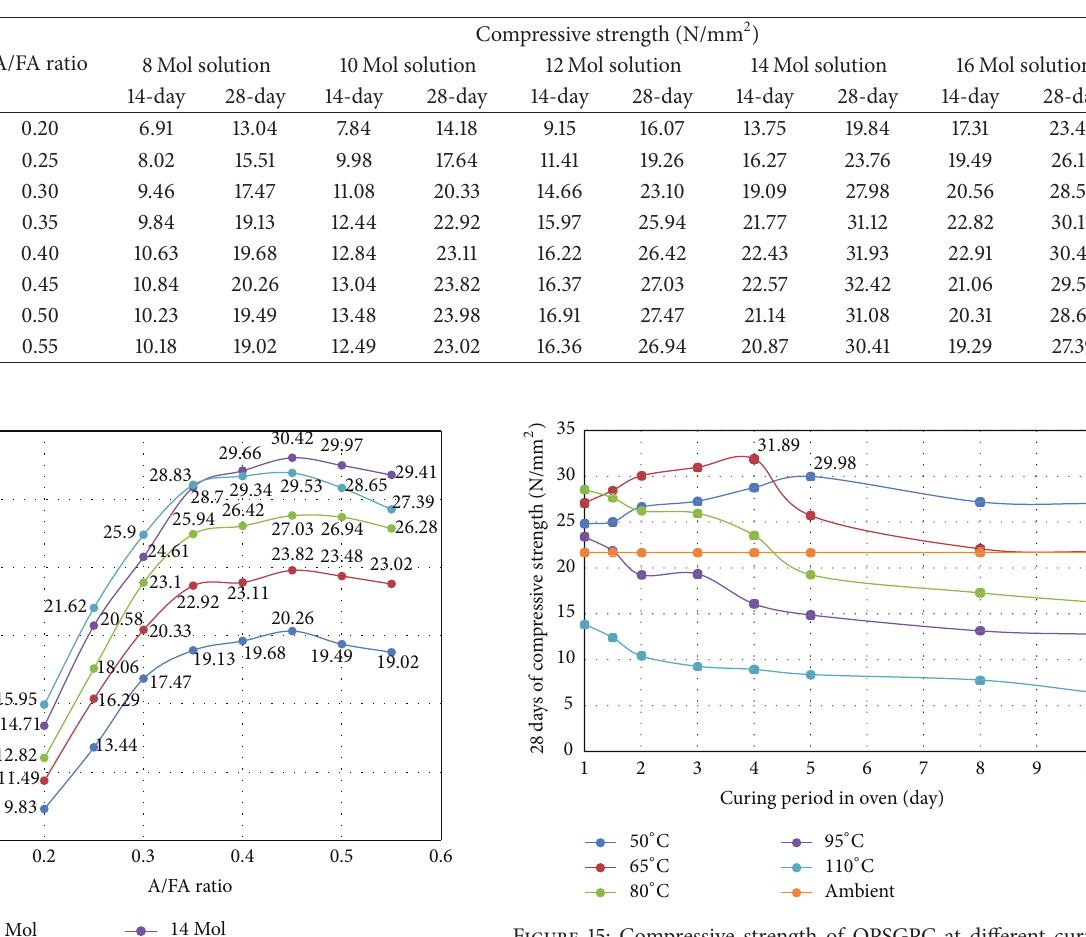
Table 8: Compressive strength of OPSGPC in different A/FA ratios (OPS used in saturated surface dry (SSD) conditions, mix proportion